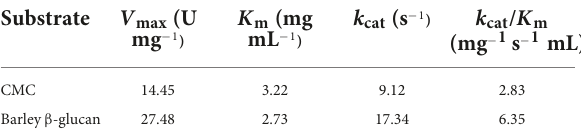
TABLE 3 Kinetic parameters of recombinant endo- β -1,4-glucanase (rGluL) determined using carboxymethylcellulose (CMC) and barley β -glucan.